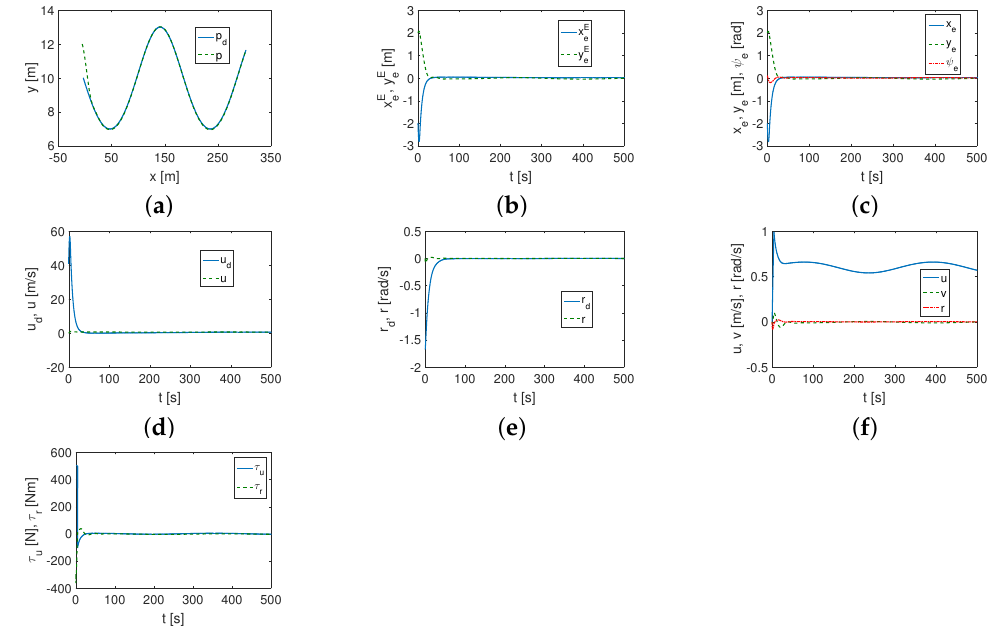
Figure 4. Simulation results for SIRENE—IQV controller and cycloid trajectory (constant distur- bances): ( a ) desired and realized trajectory; ( b ) position errors (E-frame); ( c ) position errors (B-frame) and angular error; ( d ) desired and realized velocity ( u d , u ); ( e ) desired and realized velocity ( r d , r ); ( f ) realized velocities; ( g ) applied force and torque.